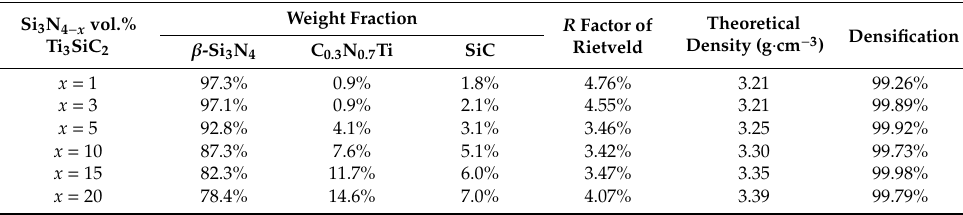
Table 1. Refinement parameters of Ti 3 SiC 2 doped Si 3 N 4 ceramics.